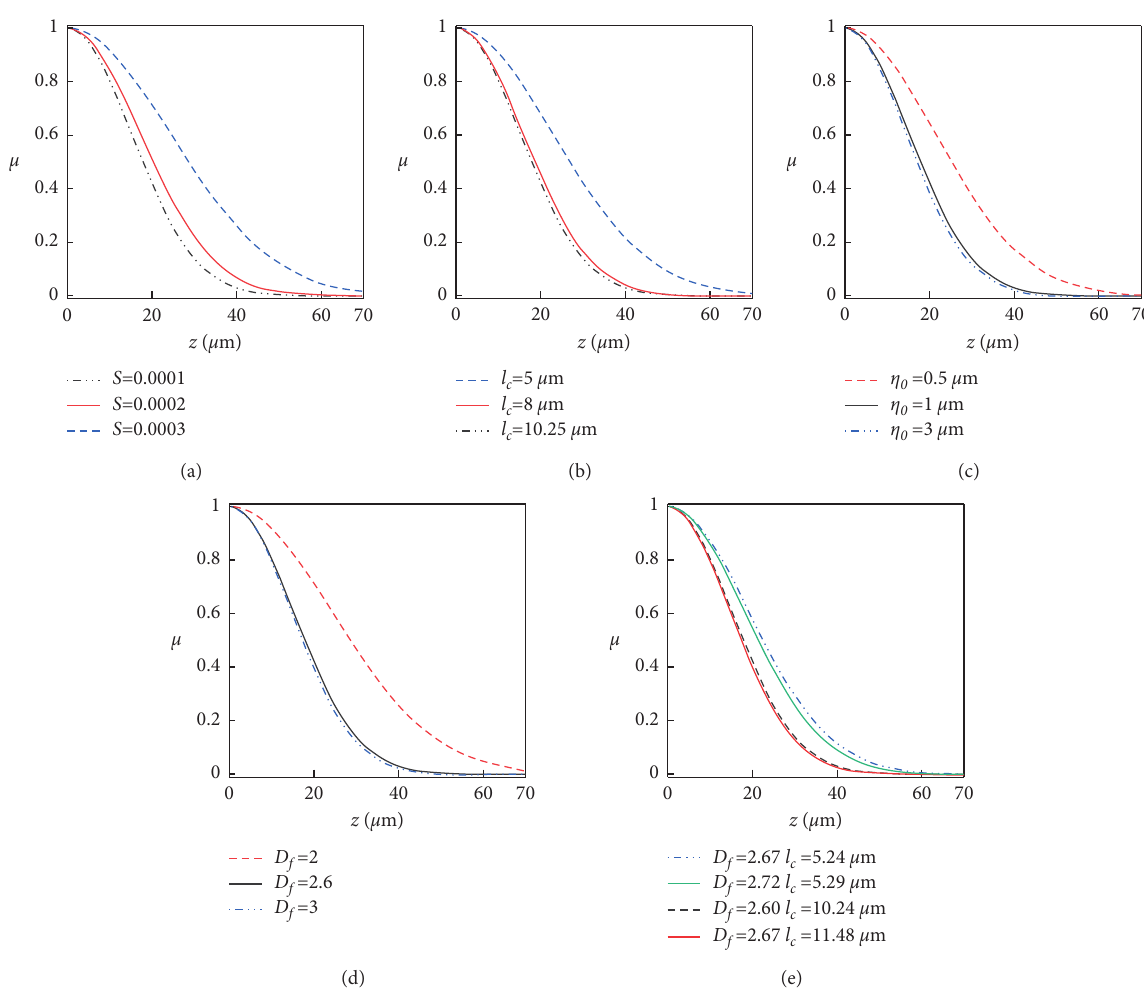
Figure 6: Modulus of the DOC at several propagation distances of TGSMA beams at propagation distance z � 200 μ m for different biological tissue parameters, (a) D f � 2.60, l c � 10.24 μ m, η 0 � 1 μ m; (b) D f � 2.60, S � 0.0001, η 0 � 1 μ m; (c) D f � 2.60, l c � 10.24 μ m, S �